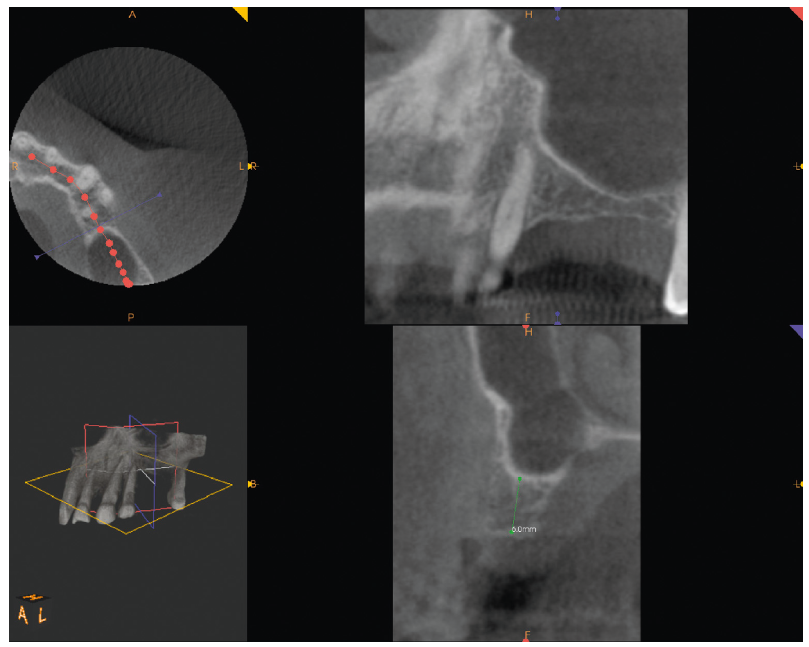
Figure 2: CT scan pre-op showing 6mm Bbh at mesial